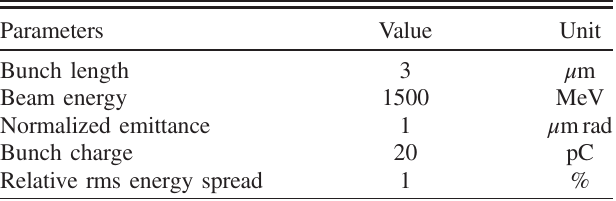
TABLE III. Parameters of the ELEGANT simulation for LPA beams.